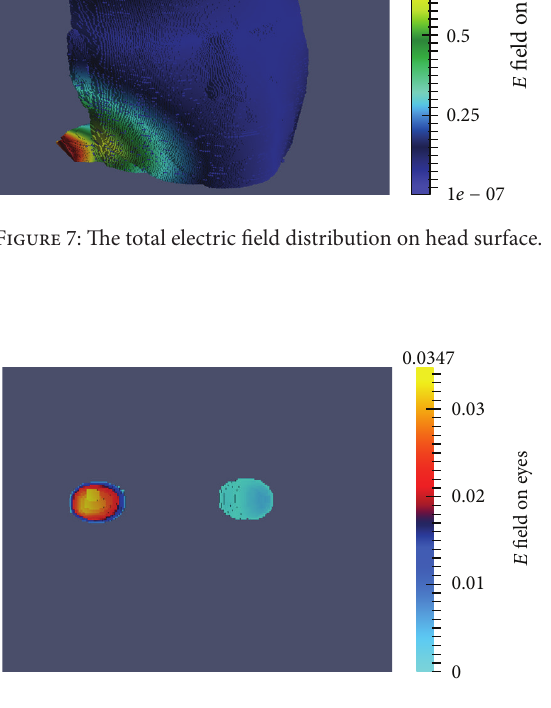
Figure 8: The total electric field distribution on